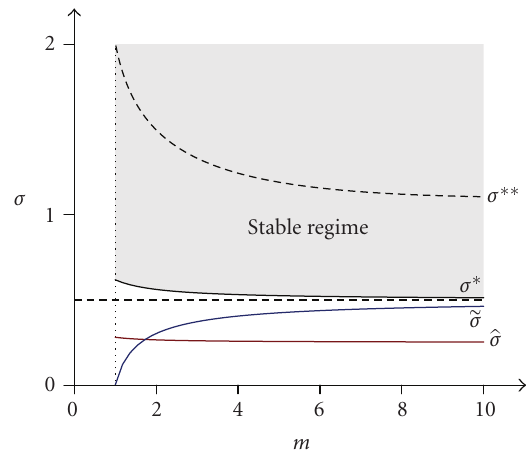
Figure 4.1. Stability parameter σ